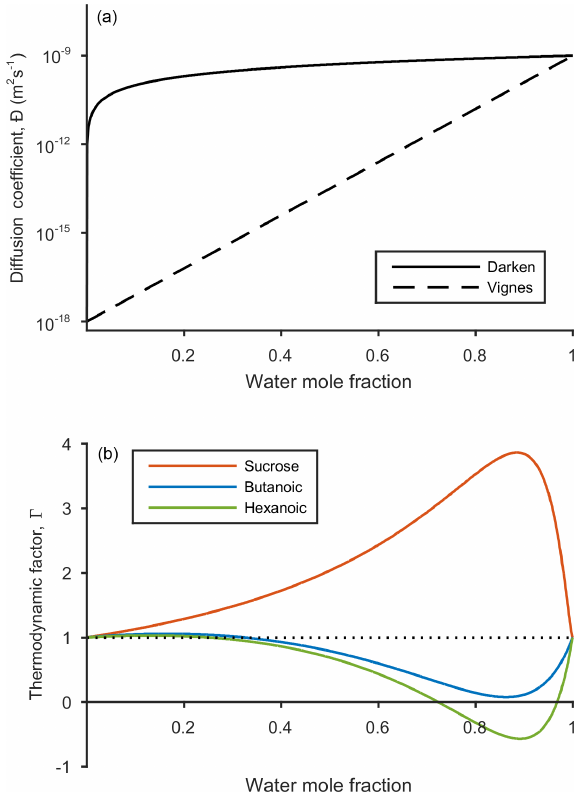
Figure 2. The dependence of diffusion coefficient and thermody- namic factor on water mole fraction. The solid and dashed black lines represent the Darken and Vignes mixing rules from Eqs. (8) and (9) respectively. The self-diffusion coefficients for water and the non-volatile species are D self = 1 × 10 − 9 and D self = 1 × 10 − 18 m 2 s − 1 respectively. The thermodynamic factors for sucrose (red), butanoic acid (blue) and hexanoic acid (green) are shown in the lower panel. Phase transitions are indicated when the thermo- dynamic factor crosses the x axis and equals zero. Activity coeffi- cients used to calculate the thermodynamic factor were found using the UNIFAC model at a temperature of